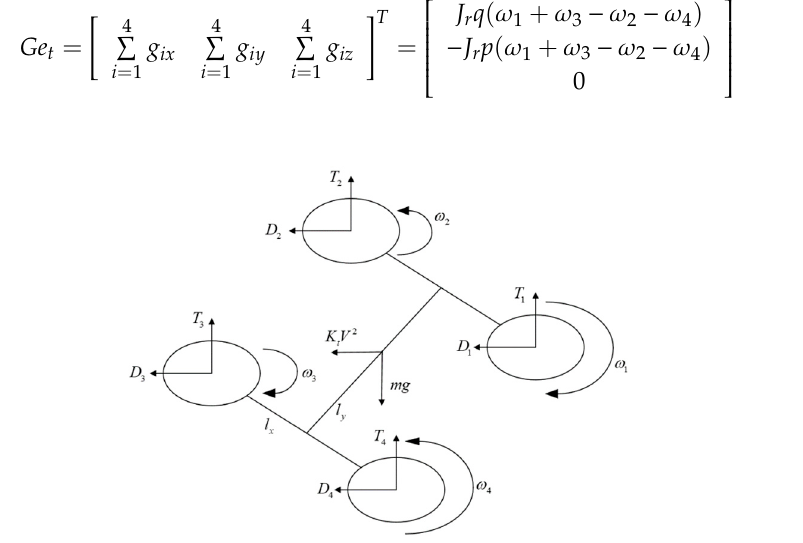
Figure 4. Quadcopter force analysis diagram.